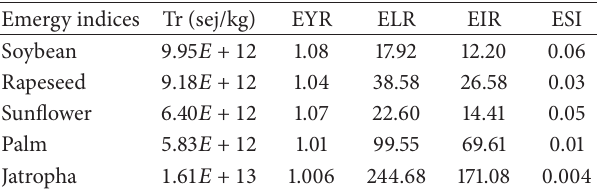
Figure 10: DEA assessment system for biodiesel